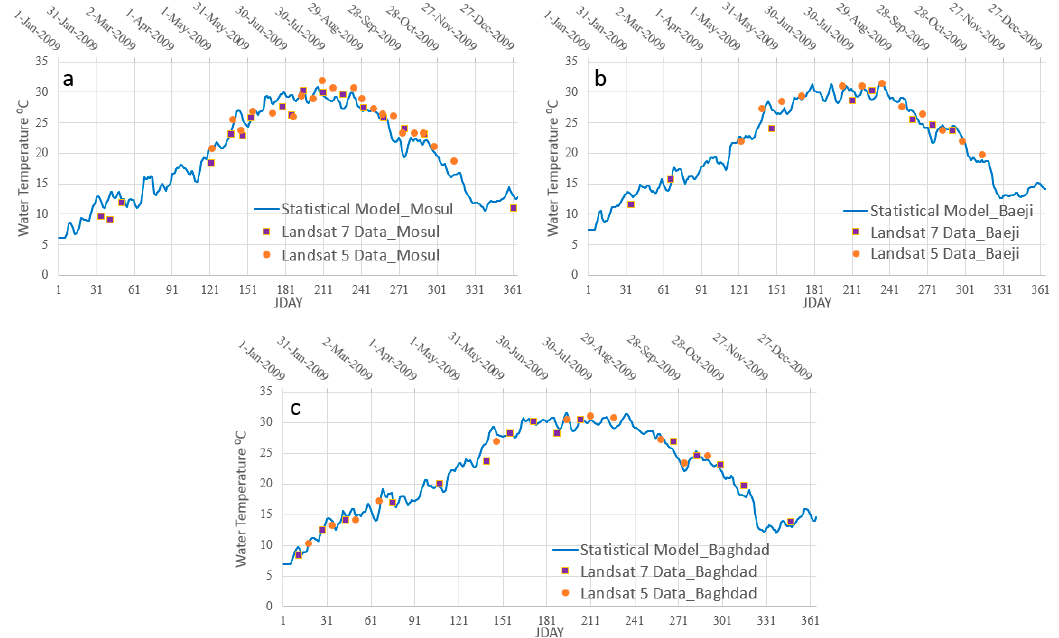
Figure 5. Satellite derived T w and daily T w estimated from T w statistical models at ( a ) Mosul Dam, ( b ) Beaji, and ( c ) Baghdad.